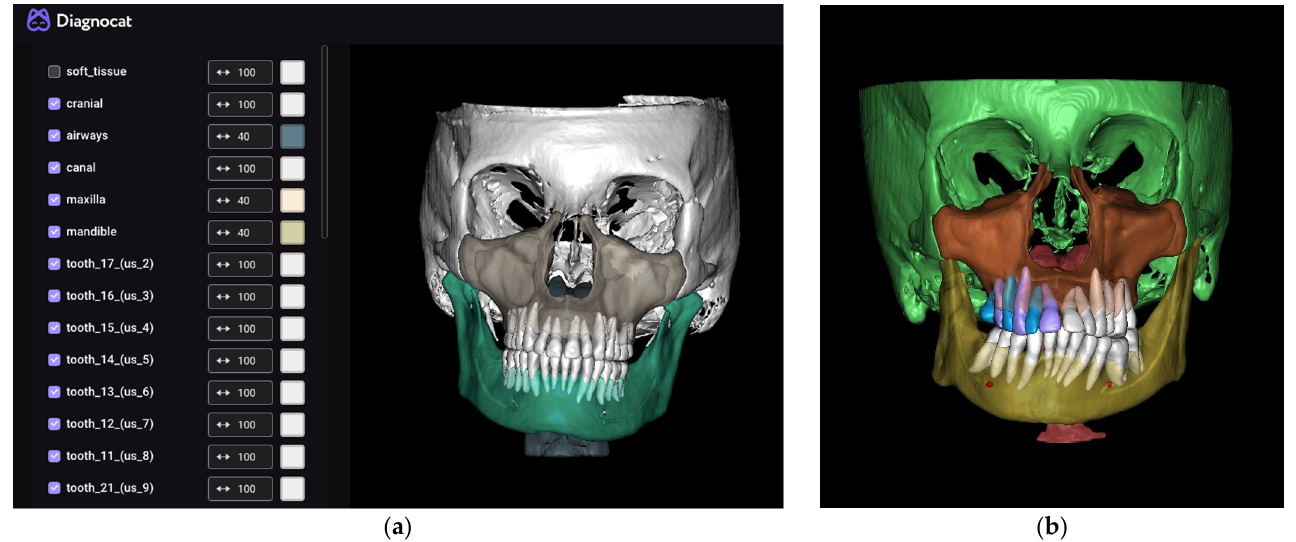
Figure 5. Segmentation of CBCT scan in Diagnocat software: ( a ) situation after fully automated CBCT segmentation, in which various structures are automatically identified, and their opacity and color can be set; ( b ) final result of AI-automated segmentation with various segmented structures can be exported to STLs or visualized in different colors and opacities.